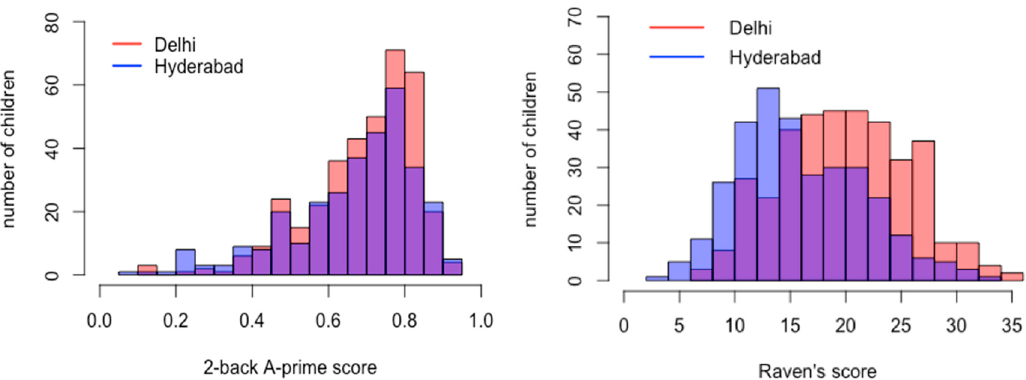
Figure 6. Distribution of scores on the 2-back task ( left graph) and on the Raven’s task ( right graph) for children from Delhi and Hyderabad. Purple areas reflect the overlap between the children from the two cities on the 2-back and Raven’s scores.